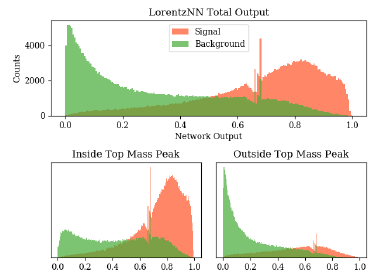
Figure 6. Output histograms for a sample Vanilla network. Lower histograms display events inside and outside of the top mass peak.